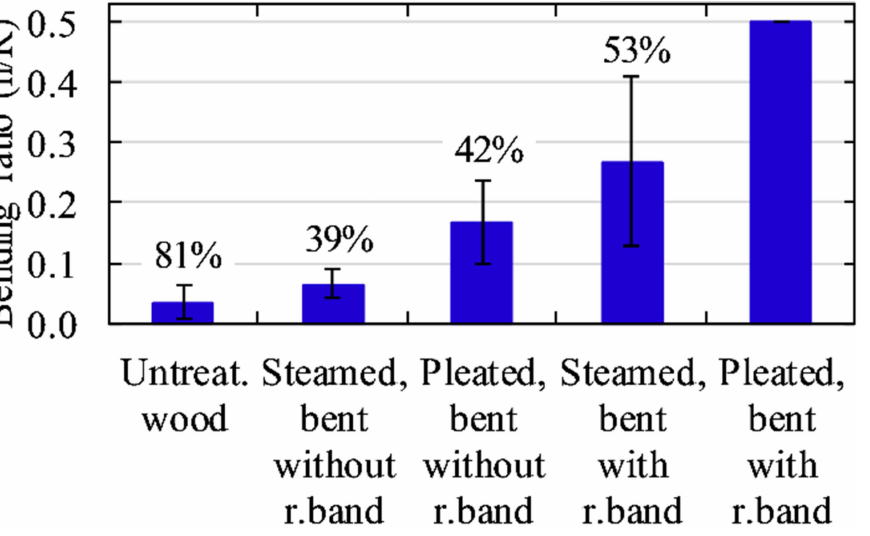
Figure 10. Average bending ratios and standard deviations of 25 mm thick beech wood using different bending processes; coefficient of variations are shown above the diagram columns (The numerical data used to plot the diagram are taken from the following sources: [3,4,12,14,16,38,57, 64,74,102,108,124,125]. Reproduced from [59], with permission from B á der, 2023. Abbreviations: untreat.—untreated; pleated—compressed along the grain; r.band—restraining